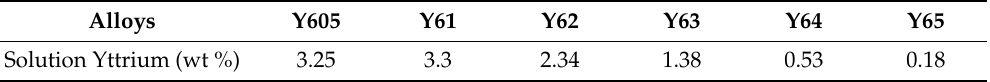
Table 2. The EDS results of solution yttrium from the Mg-6Y- x Al matrix in Figure 1.